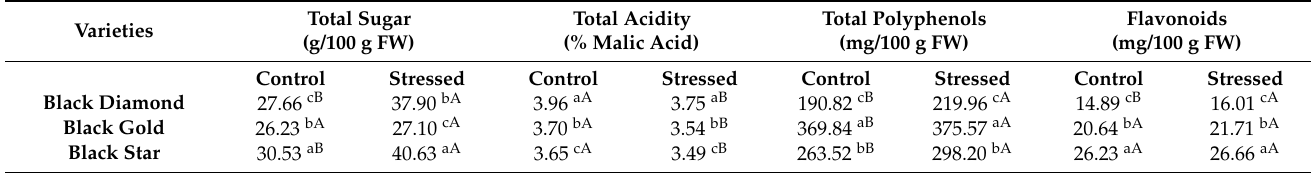
Table 2. Variation of pomological parameters in the fruits of the three plum cultivars subjected (stressed) or not (control) to moderate water